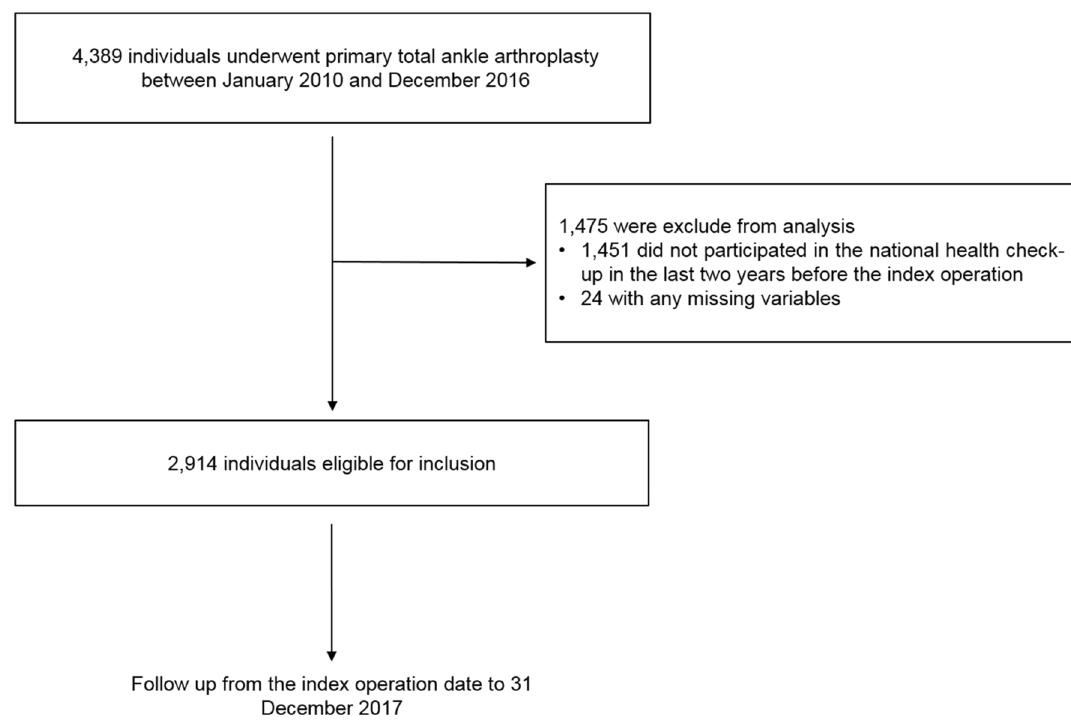
Figure 1. Flowchart of the study